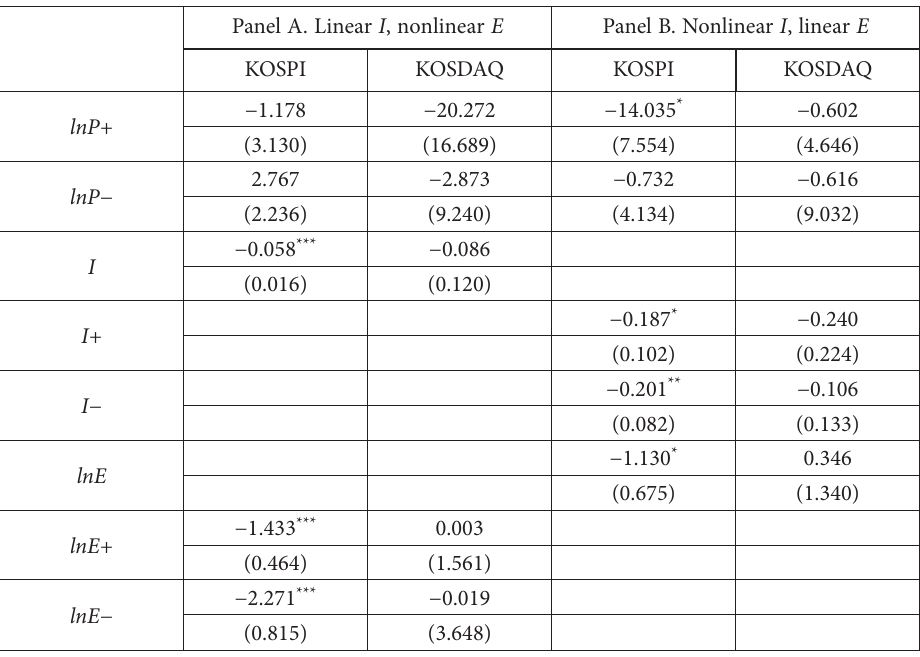
Table 5. Long-run coefficient: mixed ARDL model